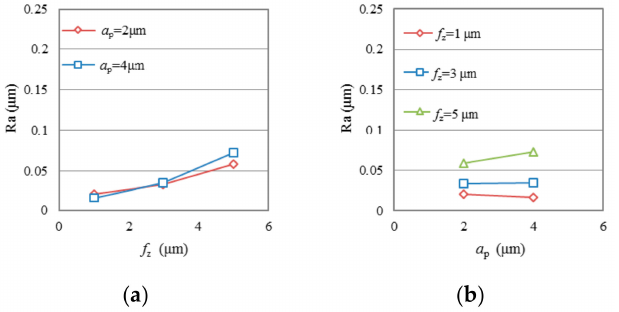
Figure 6. Surface roughness Ra as a function of ( a ) f z and ( b ) a p in test group TP.